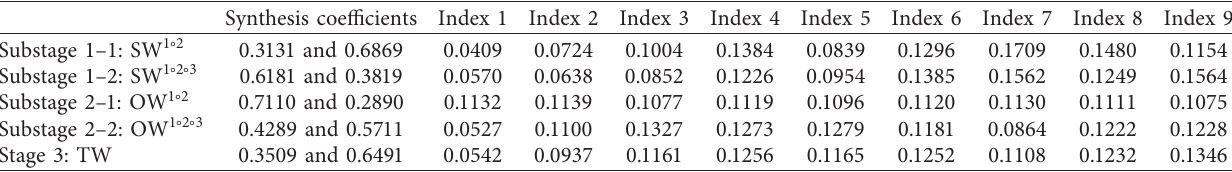
Table 12: The synthesized weight obtained in each stage.